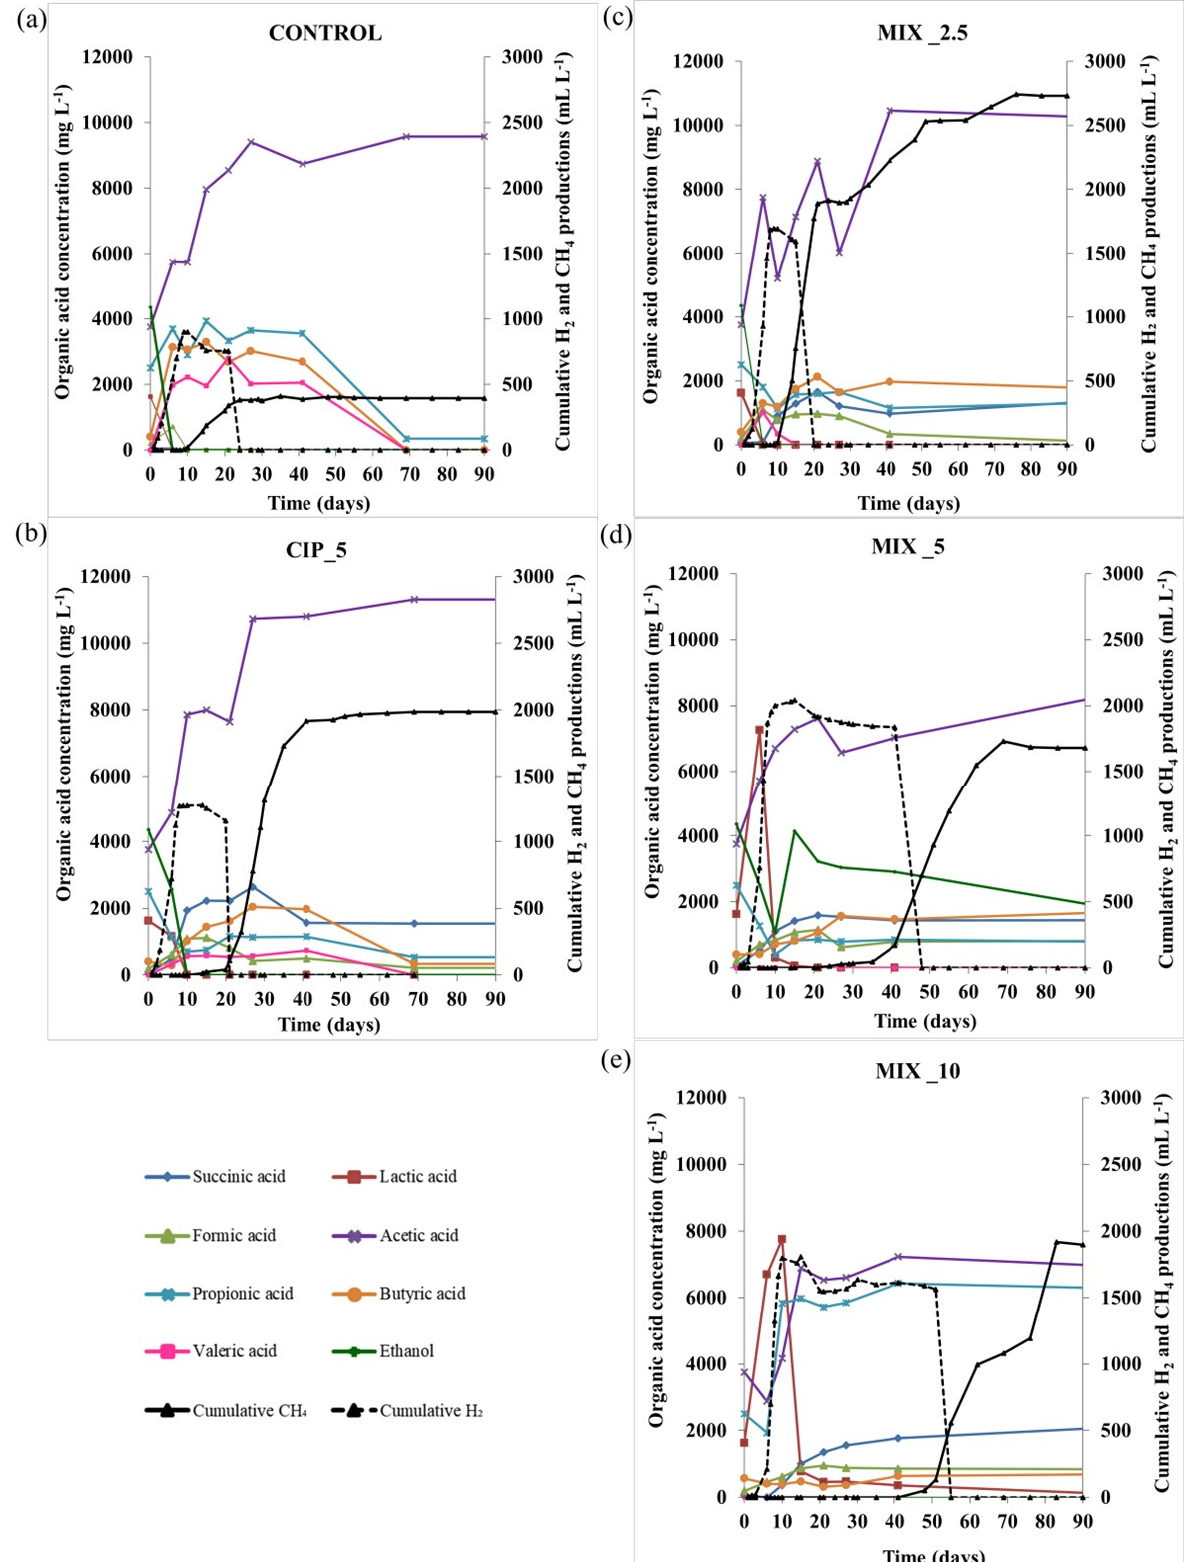
Figure 2. Organic acids and ethanol concentrations in the different conditions ( a – e ) during the anaerobic digestion process compared with H 2 and CH 4 production (black dotted and solid lines represent H 2 and CH 4 production, respectively). The standard deviations are <10%.